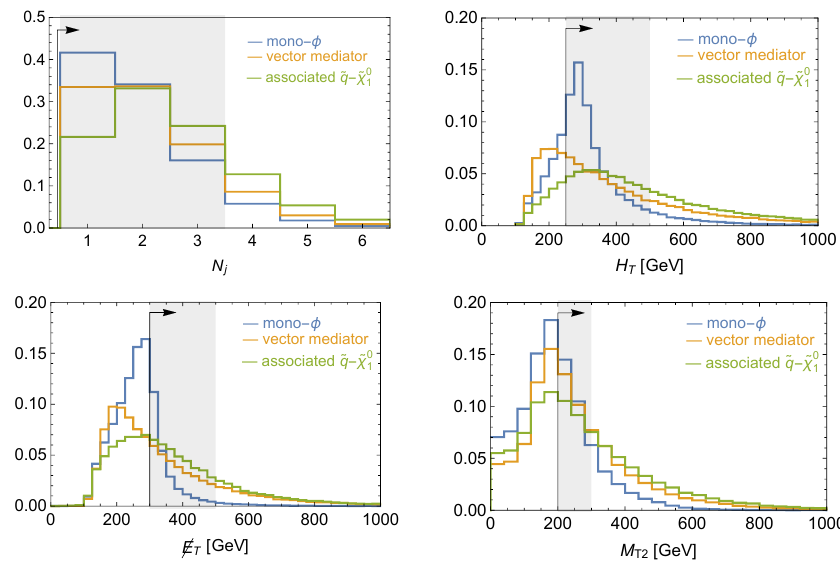
Figure 5 . Distributions of N j , H T , =E , M T 2 for the three models described in the main text. In T grey, we show the parameter range where the excess is located. The black lines with arrows indicate the lowest SR boundary for each kinematic